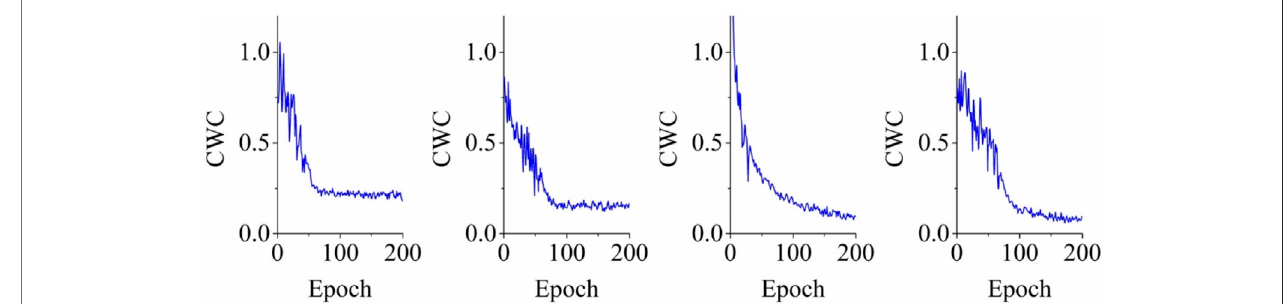
FIGURE 8 | Training KELM on the four case study buildings using original CWC.